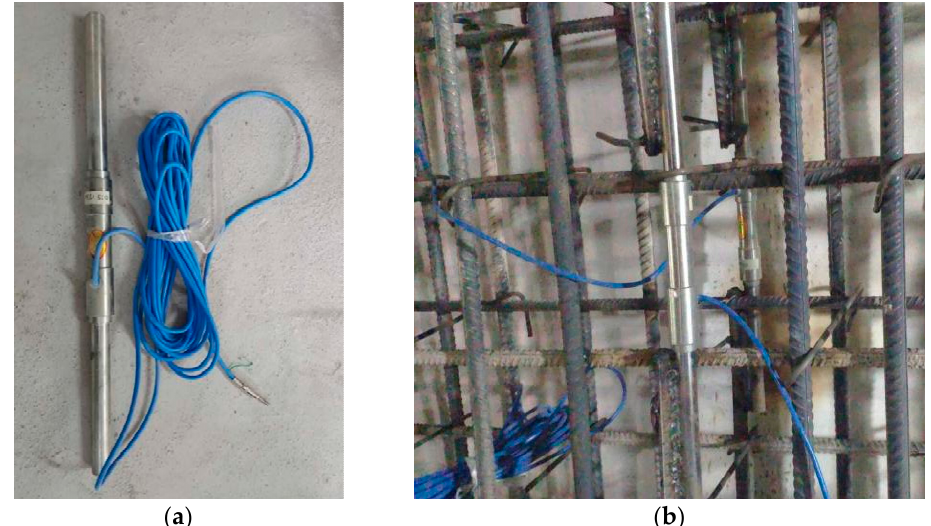
Figure 15. Field installation of reinforcement stress sensor: ( a ) reinforcement stress sensor; ( b ) in ‐ strument installation.